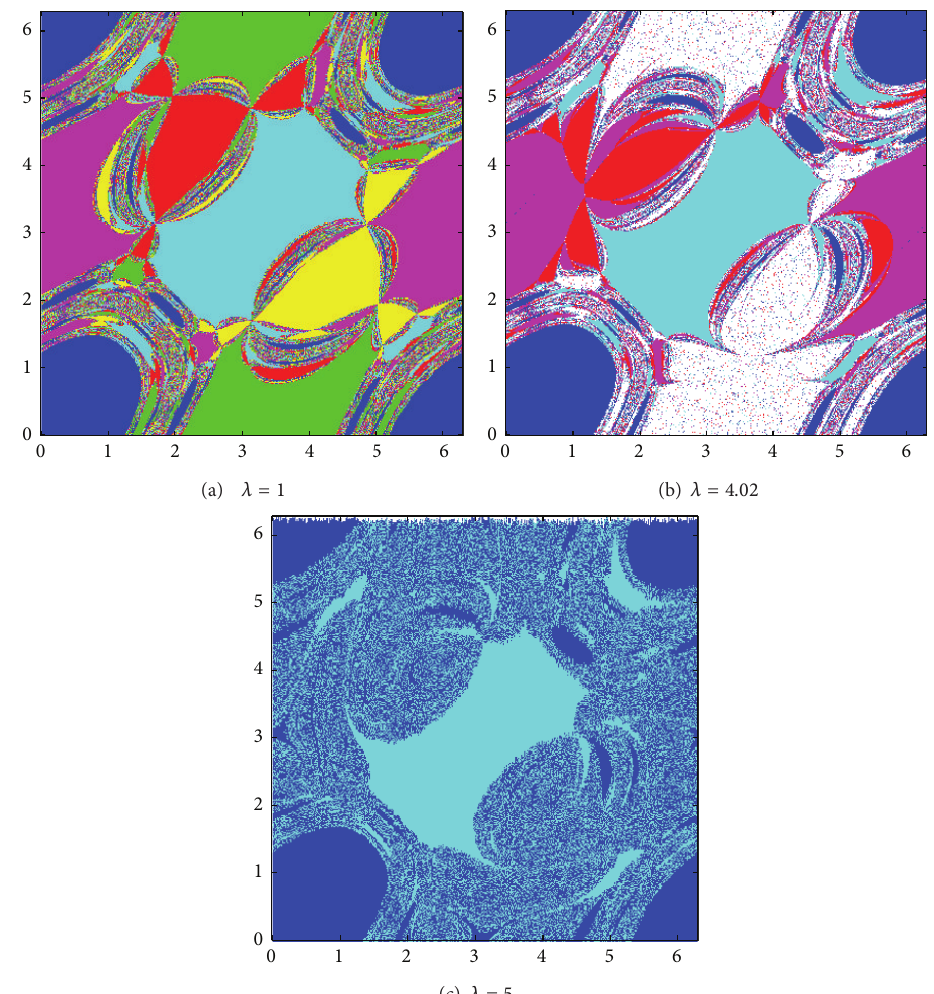
Figure 5: Convergence regions of modified 3-bus system on different loading conditions: (a) 𝜆 = 1 ; (b) 𝜆 = 4.02 ; (c) 𝜆 = 5 .